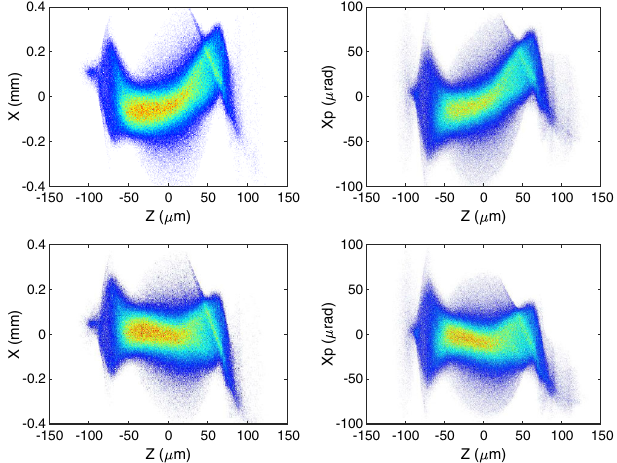
FIG. 6. Uncorrected (top) and corrected (bottom) transverse phase space of the case 3 at the entrance of the undulator.